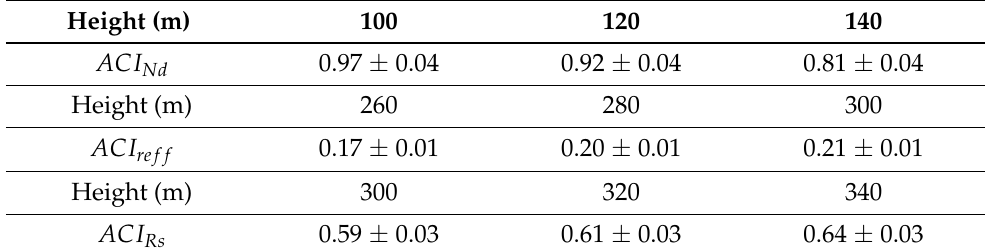
Table 2. ACI Nd , ACI ref f , and ACI Rs values for different height according to the slope of Figure 4.